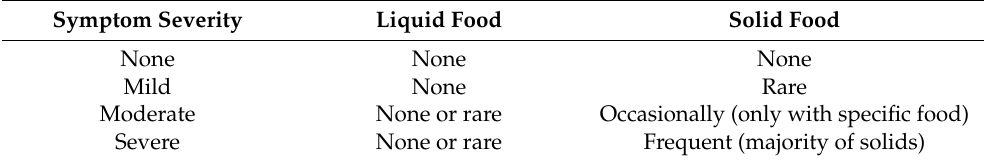
Table 1. Bazaz grading system for dysphagia. Symptom Severity Liquid Food Solid Food None None None Mild None Rare Moderate None or rare Occasionally (only with specific food) Severe None or rare Frequent (majority of solids)